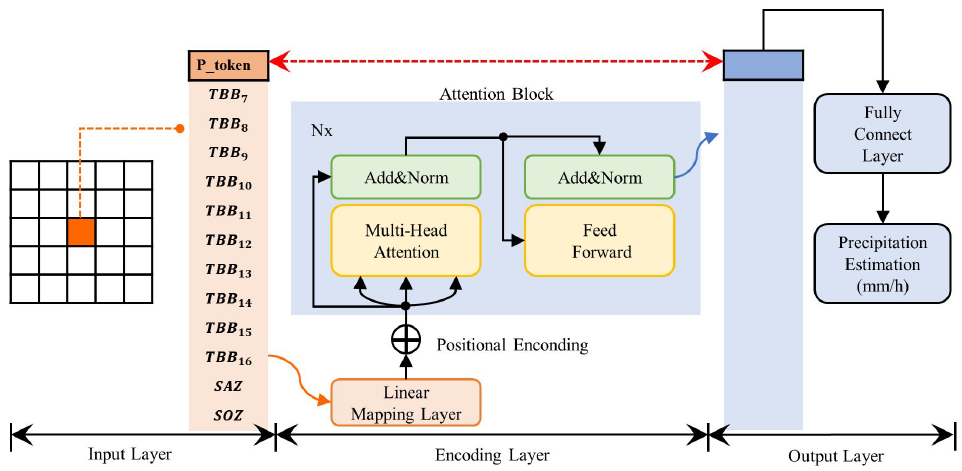
Figure 4. The general framework of PRSOT. The Input Layer describes the variables that are specifi- cally input to the model. The Encoding Layer is used to learn the nonlinear relationship between precipitation and input variables. The Output Layer further predicts precipitation (mm/h) according to the precipitation features extracted by the Encoding Layer. The proposed model is pixel-based, and all the pixels at the same time are assembled to form a full precipitation map, according to their geographic locations (latitude and longitude), after being given precipitation